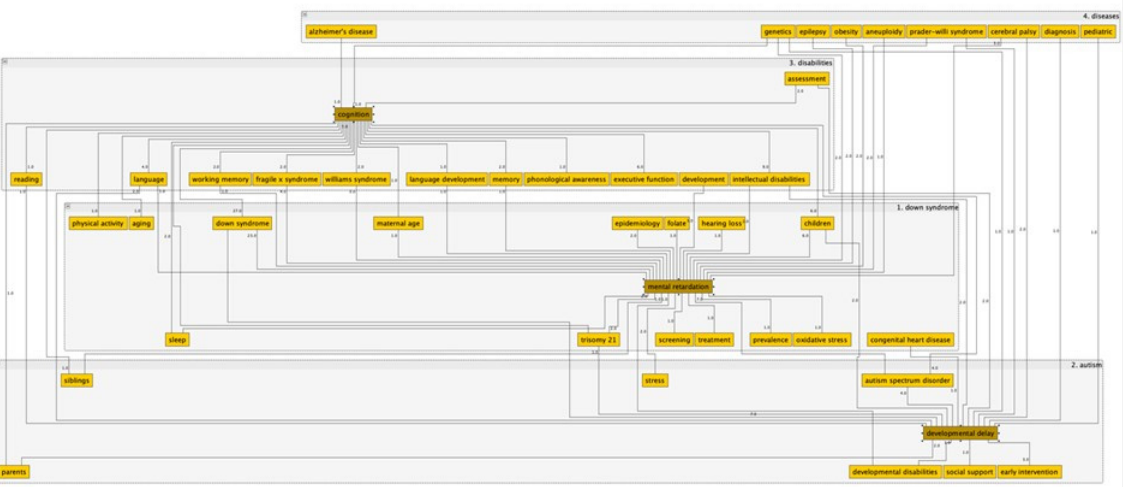
Figure 3. Conceptual space of the research, with the selection of the keywords “Down syndrome” and “games”.